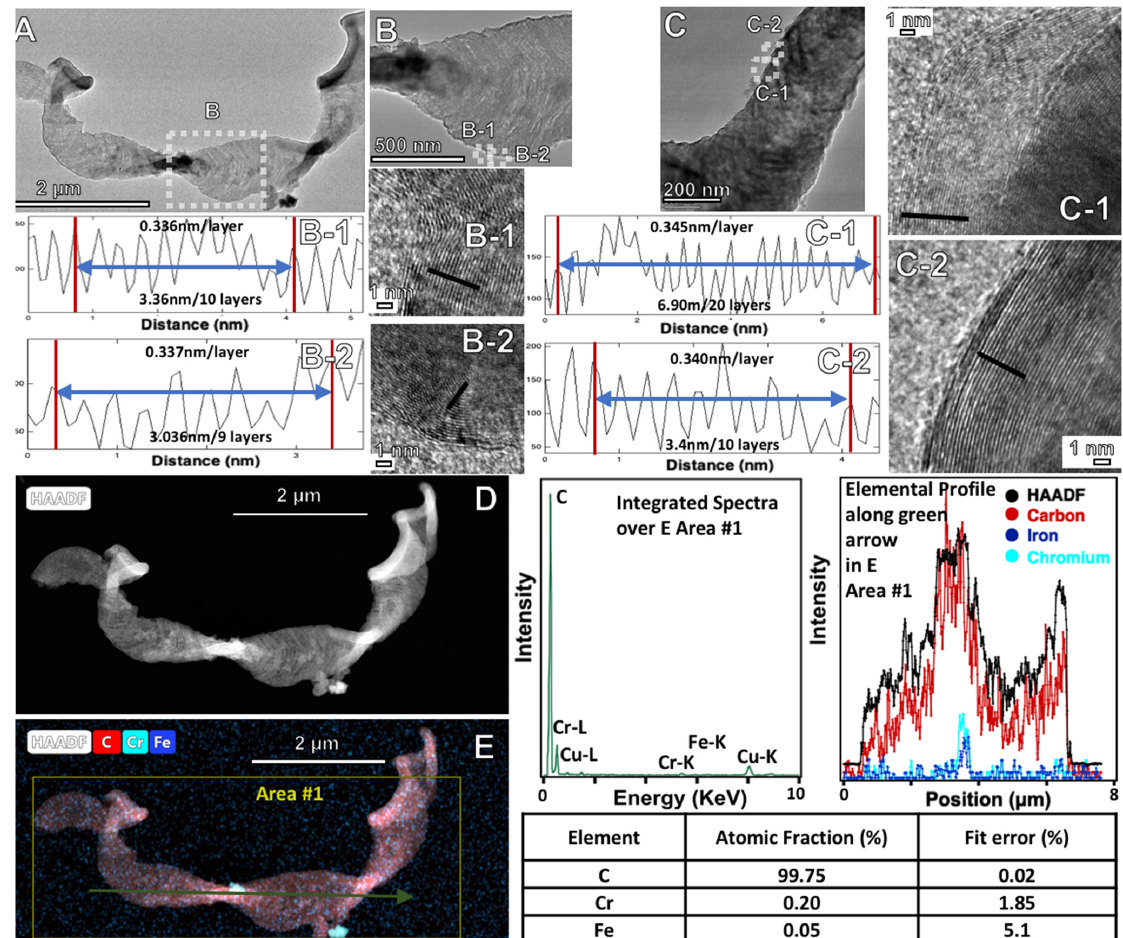
Figure 12. TEM and TEM HAADF elemental analysis of the Nano- belt carbon allotrope synthesized by molten carbonate electrolysis. ( A – C ) TEM of Nano-belts; B-1, B-2, C-1, C-2 TEM of Nano-trees with measured graphene layer thickness; ( D ) HAADF of Nano-belt with elemental analysis ( E ) and profile (middle and right side).